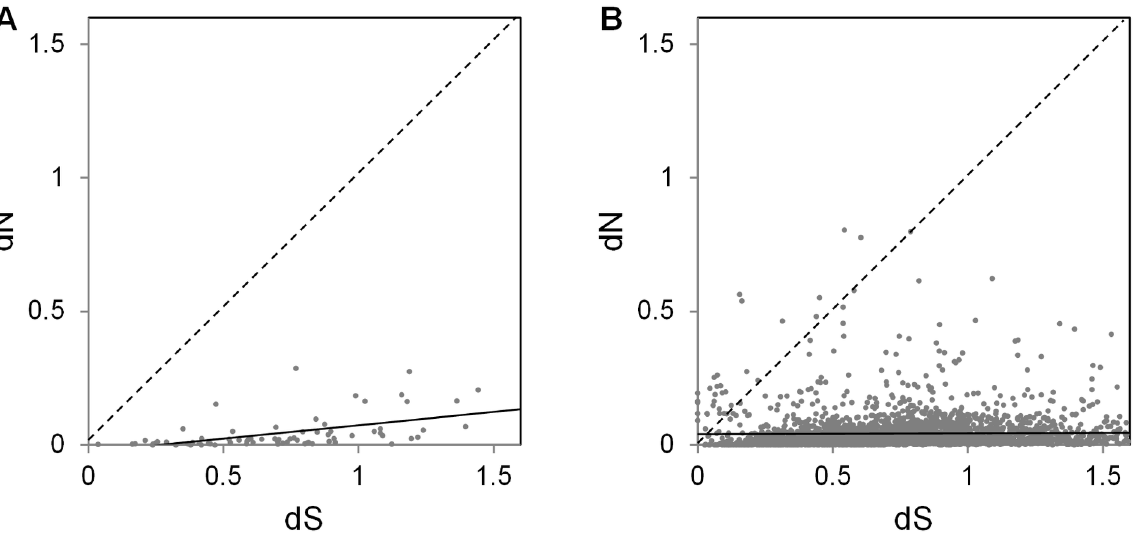
Figure 2. Estimation of evolutionary rates of Aedesalbopictus seminal fluid proteins and control proteins. A. Evolutionary rates of nonsynonymous (dN) versus synonymous (dS) changes for Ae. albopictus Sfps (72 total); B. Evolutionary rates of nonsynonymous (dN) versus synonymous (dS) changes for Ae. albopictus control proteins (3495 total; 188 not shown due to extreme values of dN or dS). For both panels, the solid line shows a regression line, and the dashed line gives a 1:1 dN/dS ratio, with points falling above the line showing dN/dS . 1.